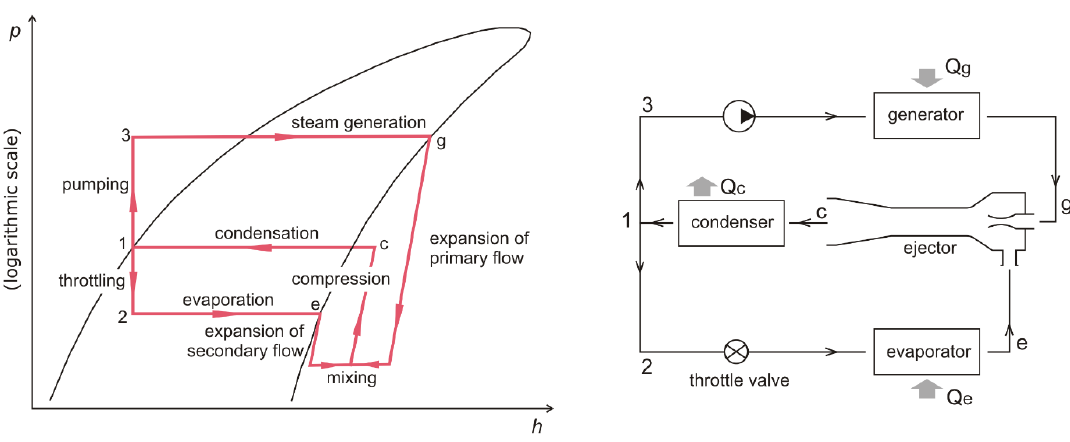
Figure 3. Ejector cycle in p–h graph and configuration diagram of ejector refrigeration system; Reproduced with permission from [29] Kasperski J.; Gil B.; Applied Thermal Engineering, Elsevier, 2014.